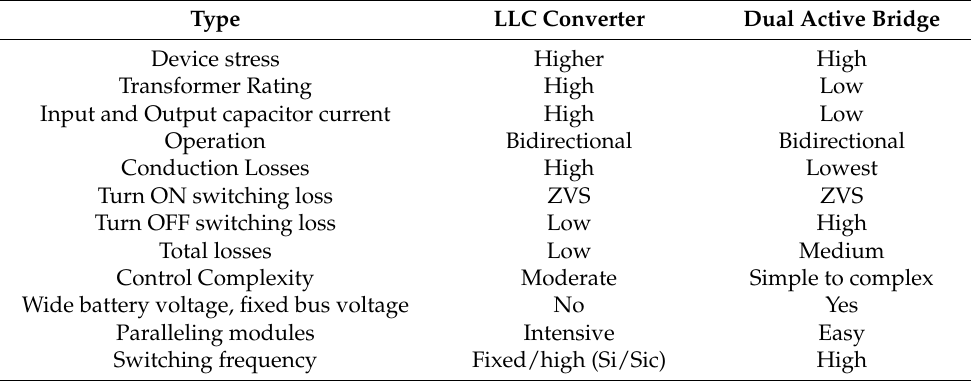
Table 4. Pros and Cons of isolated DC/DC topologies